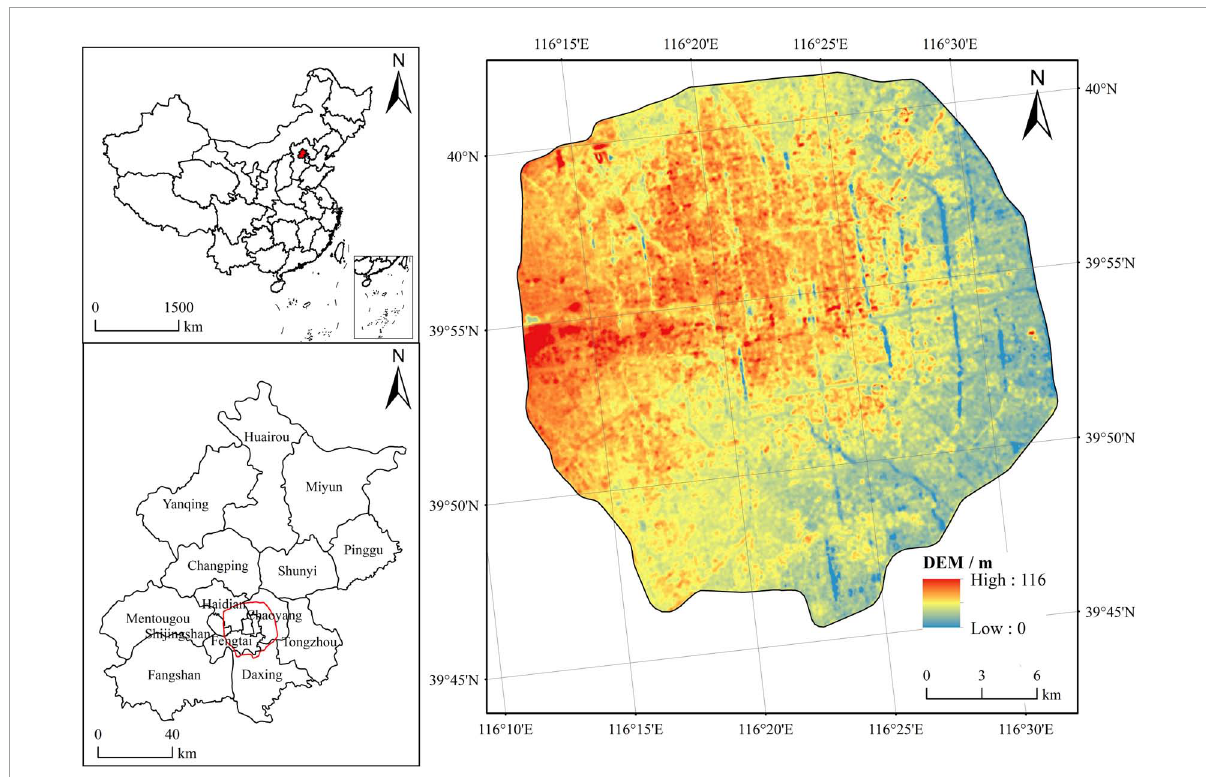
FIGURE1 Location and digital elevation model of the study area.